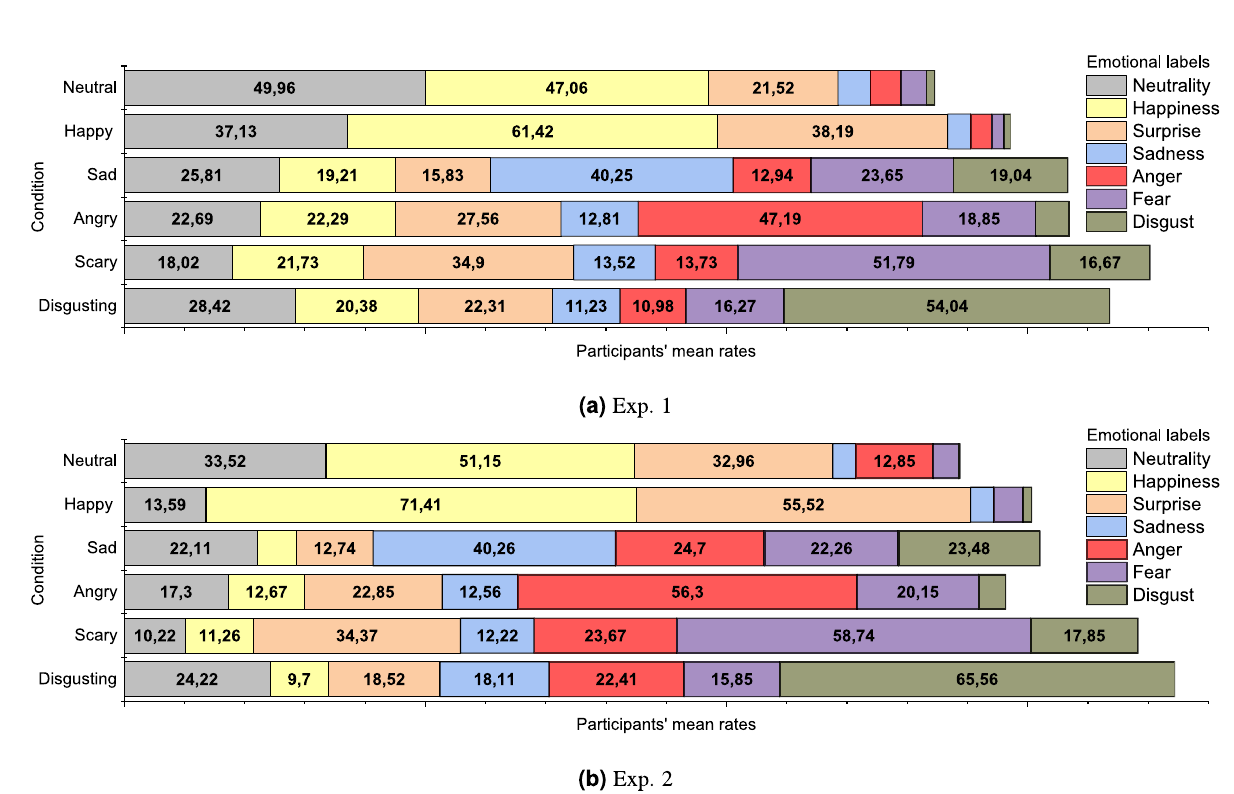
Figure 2. Participants’ mean rates for the 7 emotional labels in the two experimental setups.